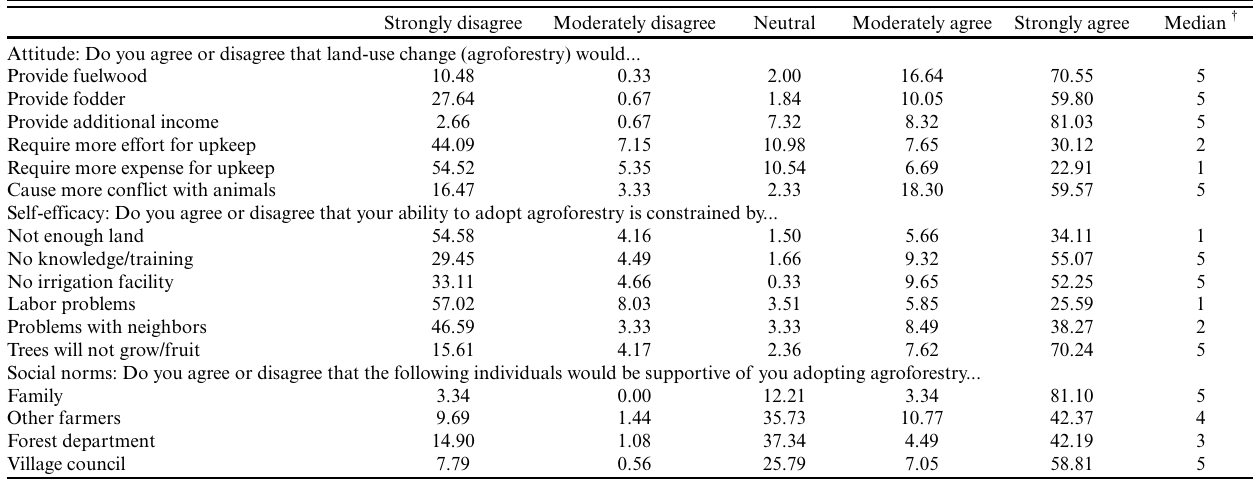
Table 2. Percentage of responses for each rank and median responses for five-point Likert scale questions to gauge respondent’s attitudes toward modifying land uses, self-efficacy, and social norms Strongly disagree Moderately disagree Neutral Moderately agree Strongly agree Median † Attitude: Do you agree or disagree that land-use change (agroforestry) would... Provide